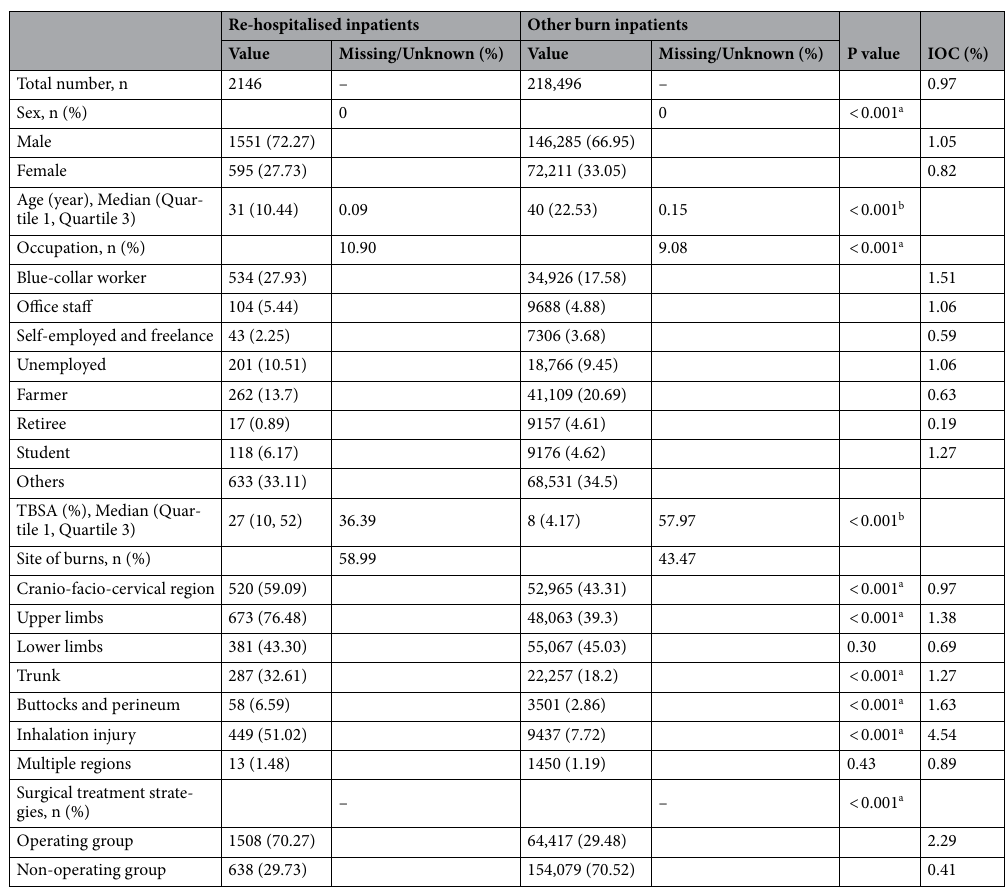
Table 1. Demographic and medical characteristics of the re-hospitalised inpatients and other burn inpatients. The denominator of percentage represented in parentheses of “Value” columns is equal to the total number of re-hospitalised inpatients or other burn inpatients subtracting the number of data missing or unknown of each variable, and the numerator is the number of each variable represented in the same cell. χ 2 –tests and Mann– Whitney U test were performed to test the difference of distributions between the re-hospitalised inpatients and other burn inpatients regard to those variables and labeled as “a” and “b” in the column of P value, respectively. IOC incidence of scar contracture-associated re-hospitalisation. TBSA total body superficial